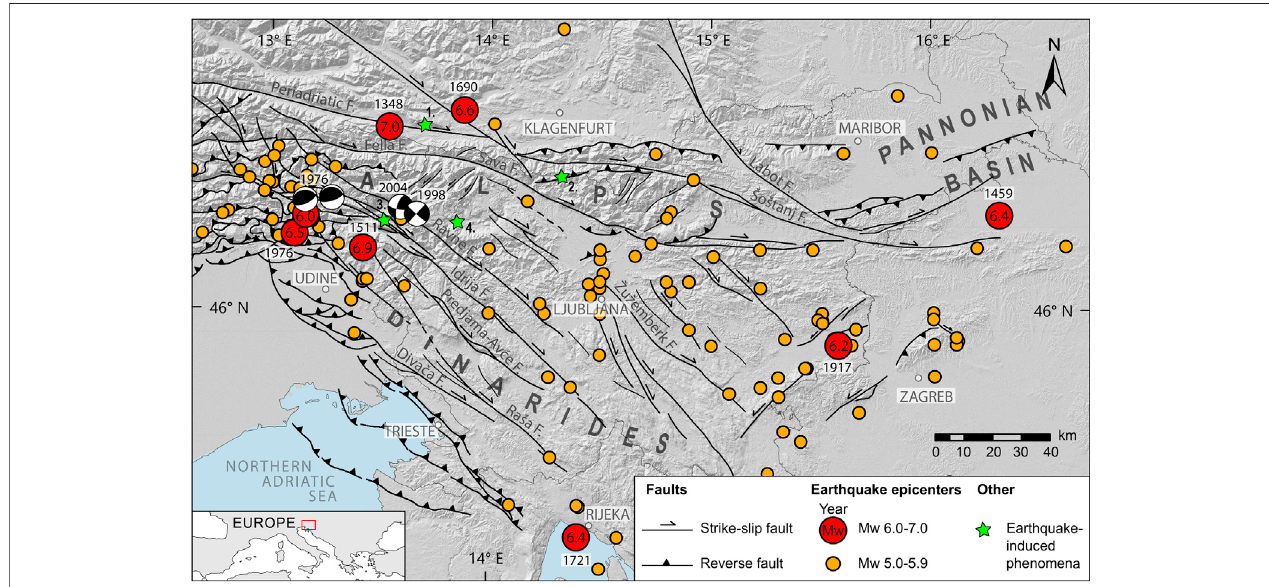
FIGURE 1 | Generalized seismotectonic map of the junction between the Alps, the Dinarides and the Pannonian Basin tectonic domains with plotted signi fi cant seismicity (M w ≥ 5.0). Faults west of Slovenia are summarized after Poli and Zanferrari (2018). Earthquakes are from SHEEC catalogs 1000 – 1899 (Stucchi et al., 2012) and 1900 – 2006 (Grünthal and Wahlstrom, 2012). Focal mechanisms for M w > 5.0 events (Bajc et al., 2001; Pondrelli et al., 2006; Kastelic, 2008). Earthquake induced phenomena: 1 - Dobratsch, 2 - Veliki vrh, 3 - Srpenica, 4 - Lake Bohinj.